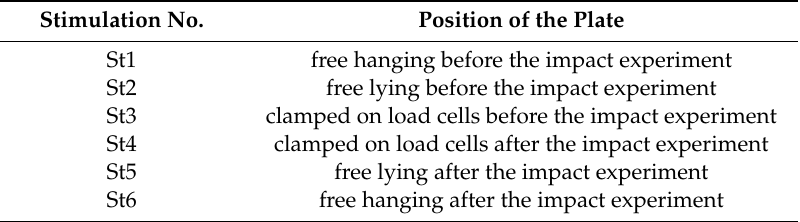
Table 4. Time points of the eigenfrequency determination with designation.